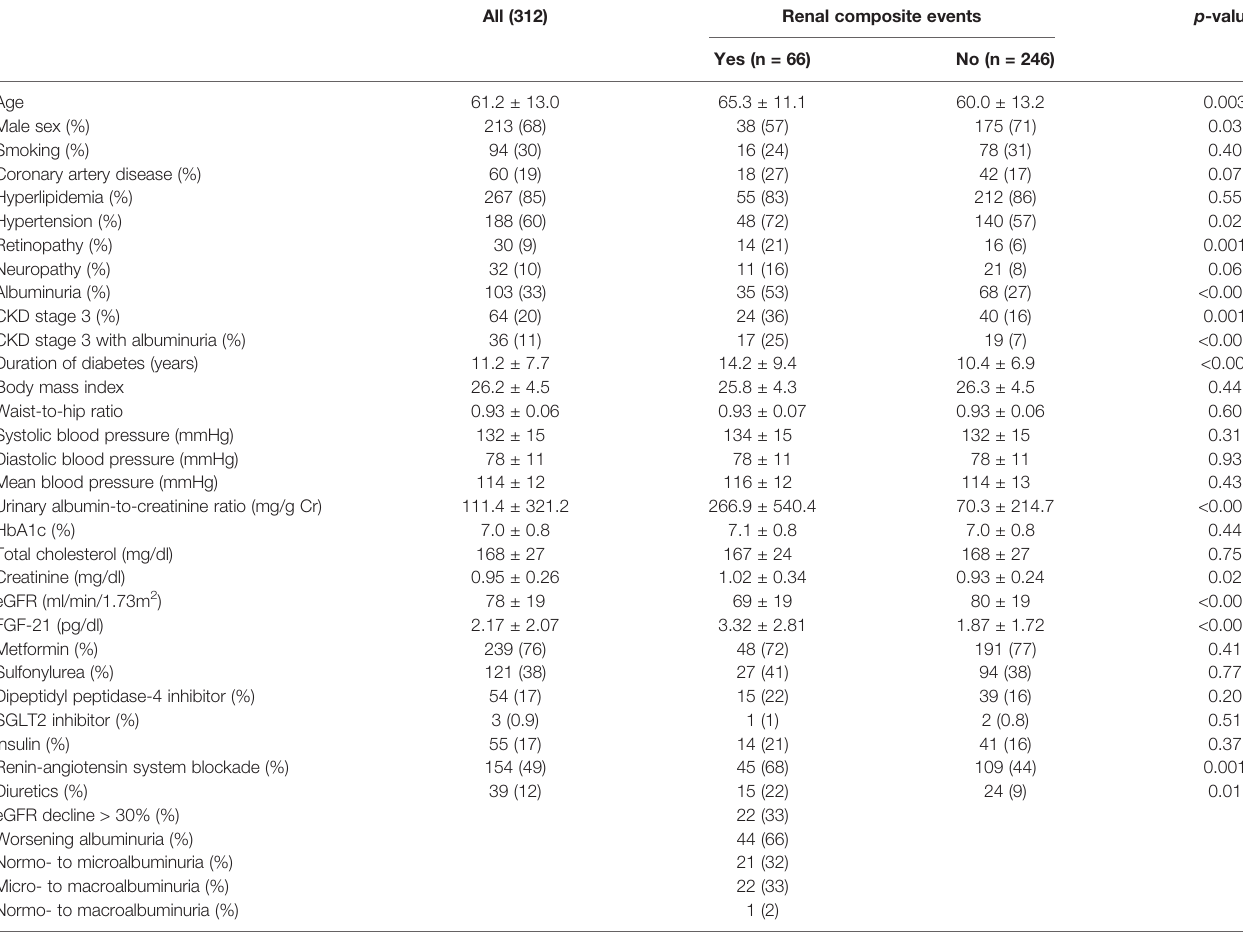
TABLE 1 | Baseline characteristics of subjects with T2DM grouped by the occurrence of renal composite events or not.